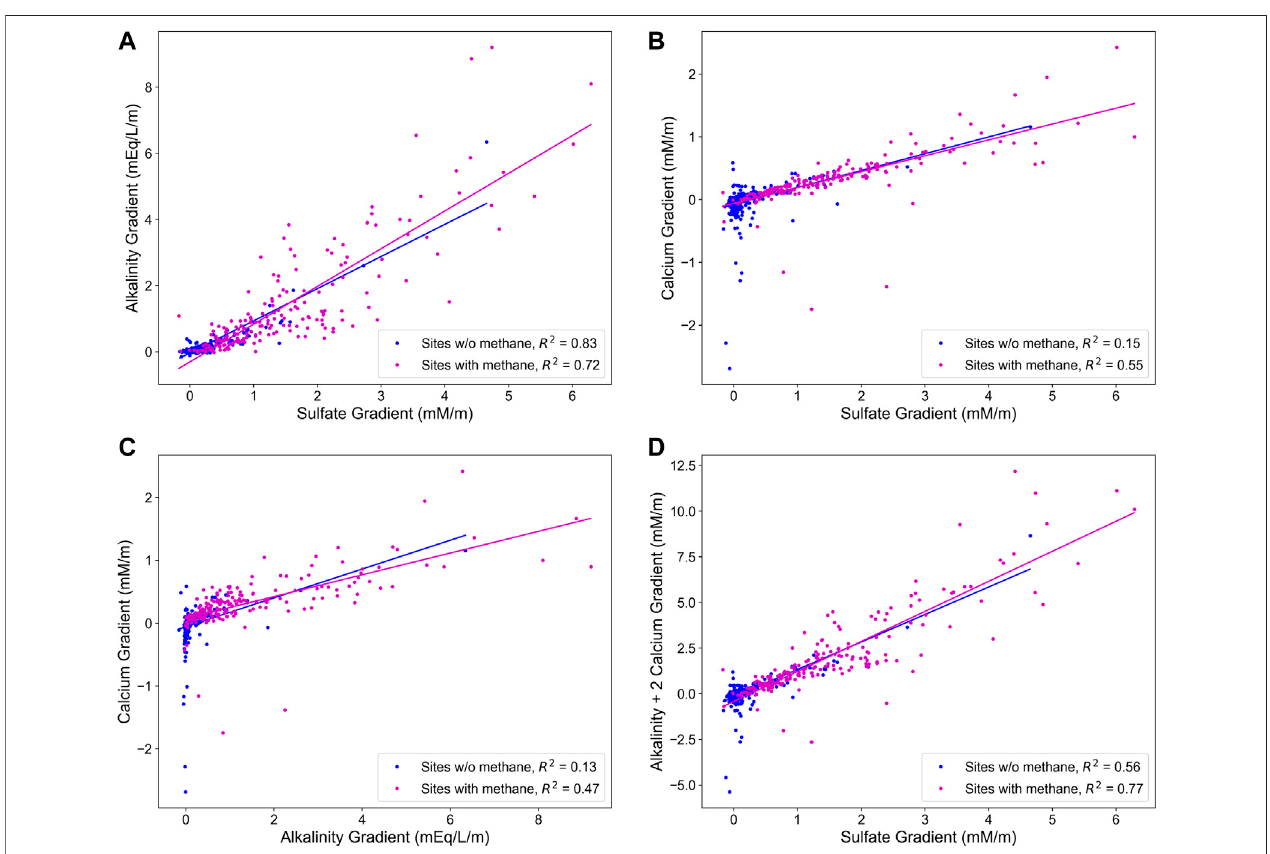
FIGURE5| Fromtopleft,correlationsbetweentheconcentrationgradientsofsulfatevs.alkalinity,sulfatevs.calcium,calciumvs.alkalinity,andsulfatevs.alkalinity + 2*Calcium.